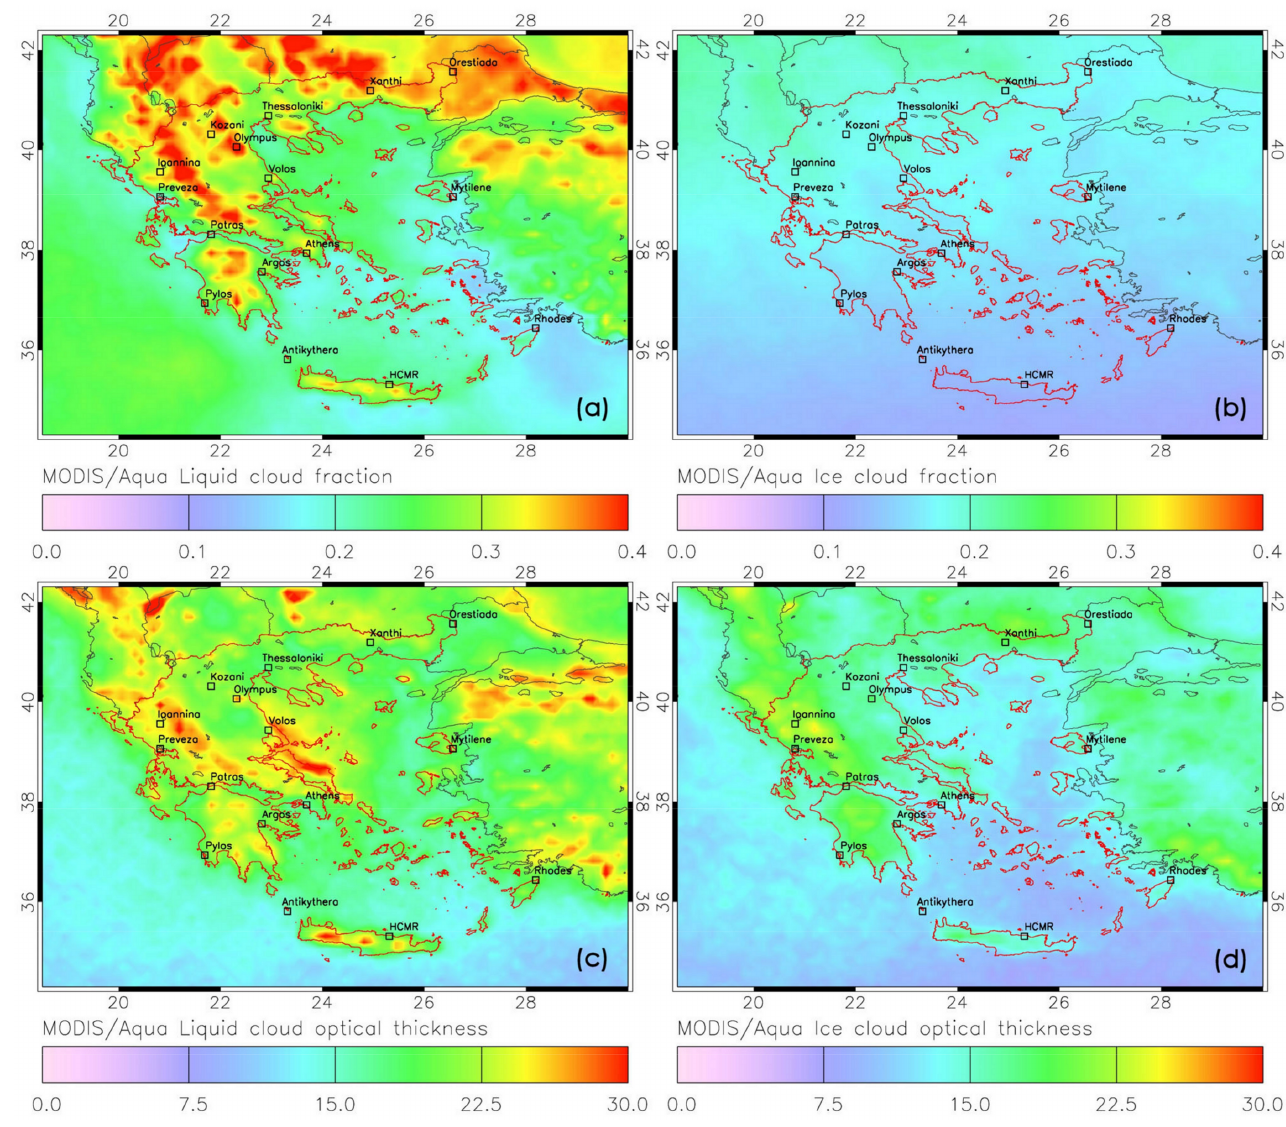
Figure 5. Maps with the annual average MODIS/Aqua ( a ) liquid cloud fraction, ( b ) ice cloud fraction, ( c ) liquid cloud optical thickness and ( d ) ice cloud optical thickness over the area of interest for the period